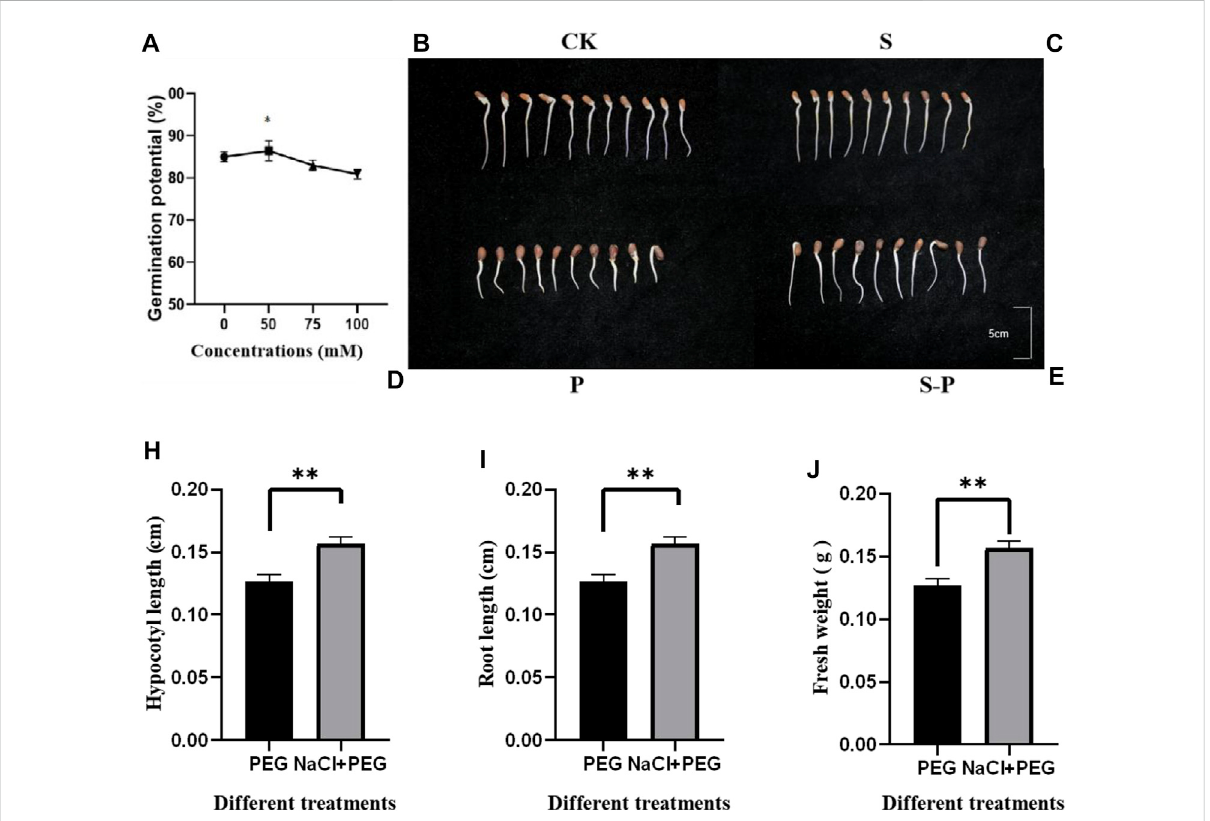
FIGURE 1 Germination potential under four different concentrations and four different treatments. (A) Germination potential after (0, 50, 75 and 100 mM NaCltreatment) (B) CK(0 MmNaCl+0%PEG6000Figure) (C) S50 mMNaCl+0%PEG6000 (D) (0 MmNaCl+15%PEG6000) (E) (50 mMNaCl+15% PEG6000) (H – J) Changes in hypocotyl, root length and fresh weight between